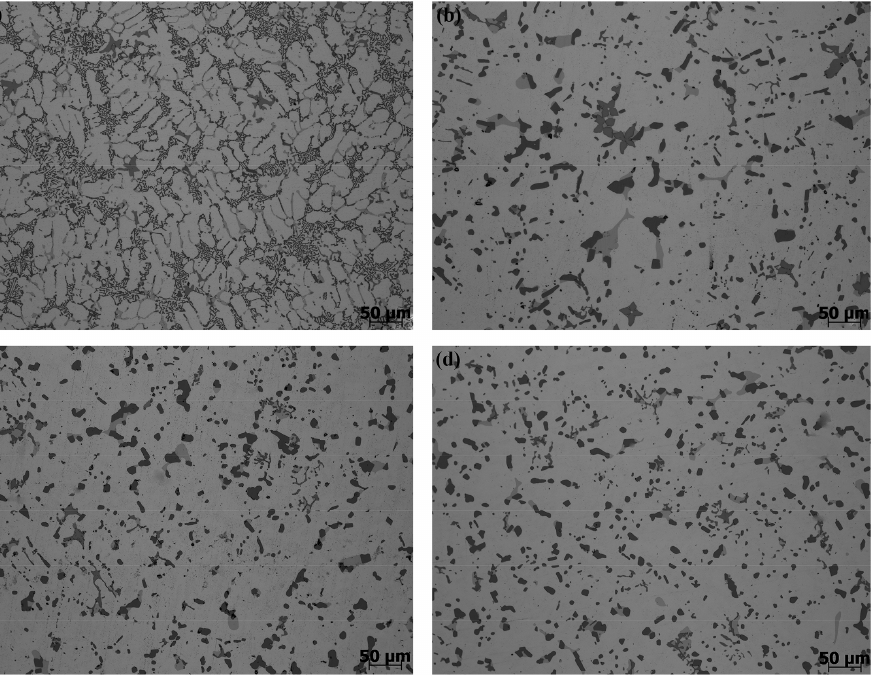
Figure 5: Optical micrographs of Al-Si-Cu-Mg alloys: (a) as-cast state; (b) solution treated; (c) aging-treated at 180 ℃ for 2h; (d) aging-treated at 180 ℃ for